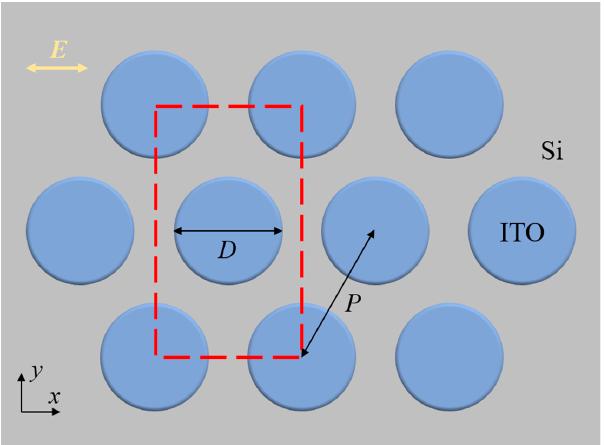
Figure 1. Illustration of the indium–tin–oxide (ITO) nanodisk array and the numerical simulation region. The ITO nanodisks with diameter D are arranged in a hexagonal array on a Si substrate. The red dashed line indicates the unit cell in the simulation, and the incident light is polarized in the x